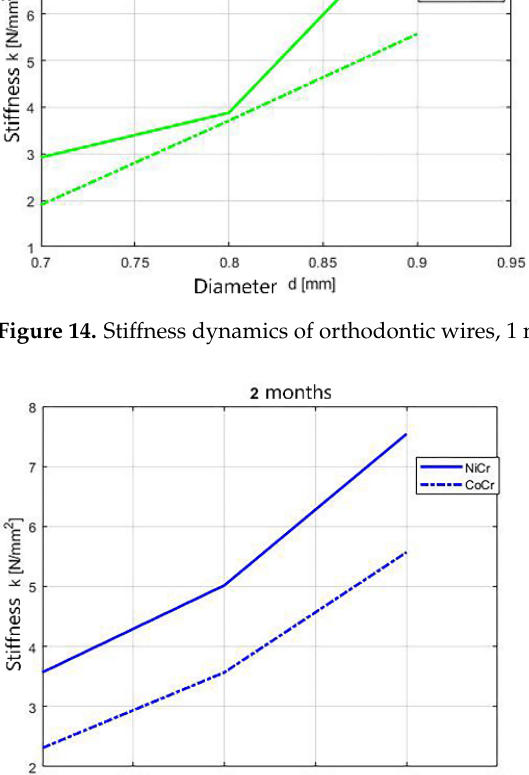
Figure 15. Stiffness dynamics of orthodontic wires, 2 months immersion.